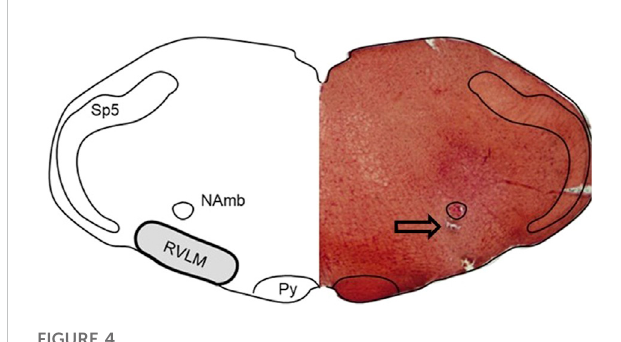
FIGURE 4 Histological veri fi cation of injection site. Representative photomicrograph of a neutral red-stained hemi-section (right) juxtaposed with a diagram outlining the anatomical landmarks designating the region of the RVLM (left). The RVLM is well-de fi ned anatomicallyintheliteraturebyothersandus(Dampney,1994;Guyenet, 2006;Mischel &Mueller, 2011;Schreihofer &Sved,2011;Subramanian& Mueller, 2016) as being located within 500 μ m of the caudal pole of the facial motor nucleus; the area ventral to the compact portion of the nucleus ambiguus (NA); lateral to the pyramidal tracts (py); and medially to the spinotrigeminal nucleus (Sp5). The anatomical representation (left) was created by tracing the neutral-red stained hemi-section, and structures wereidenti fi edwiththeaidofastandardratatlas(Paxinosand Watson,2007).Arrowrepresentslocationofthepipettetipjustventralto the compact portion of the